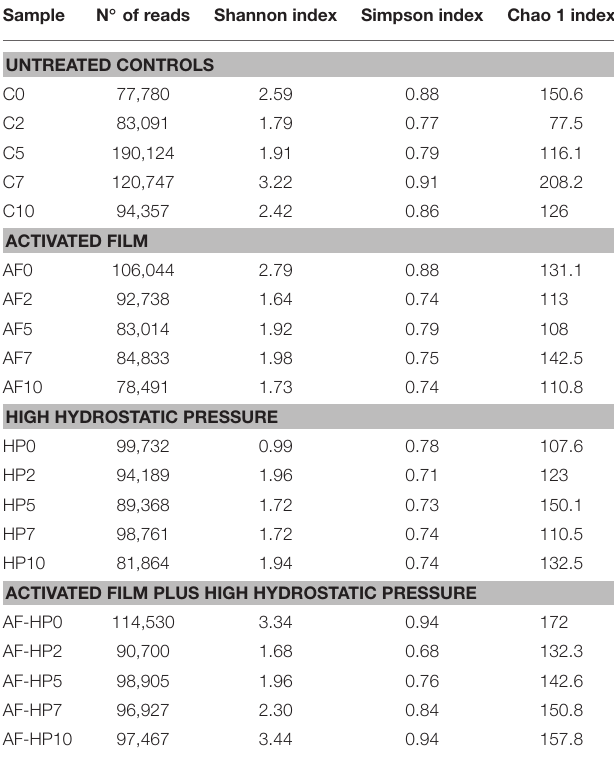
TABLE 2 | Number of sequences (reads) and observed diversity for 16S rRNA amplicons for the different samples analyzed in this study.